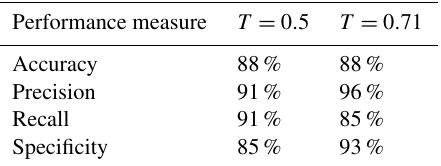
Table 1. Performance measures for the classification of profiles from the SWISS data set based on the manually determined weak layers and using two different thresholds ( T ): 0.5 (default) and 0.71